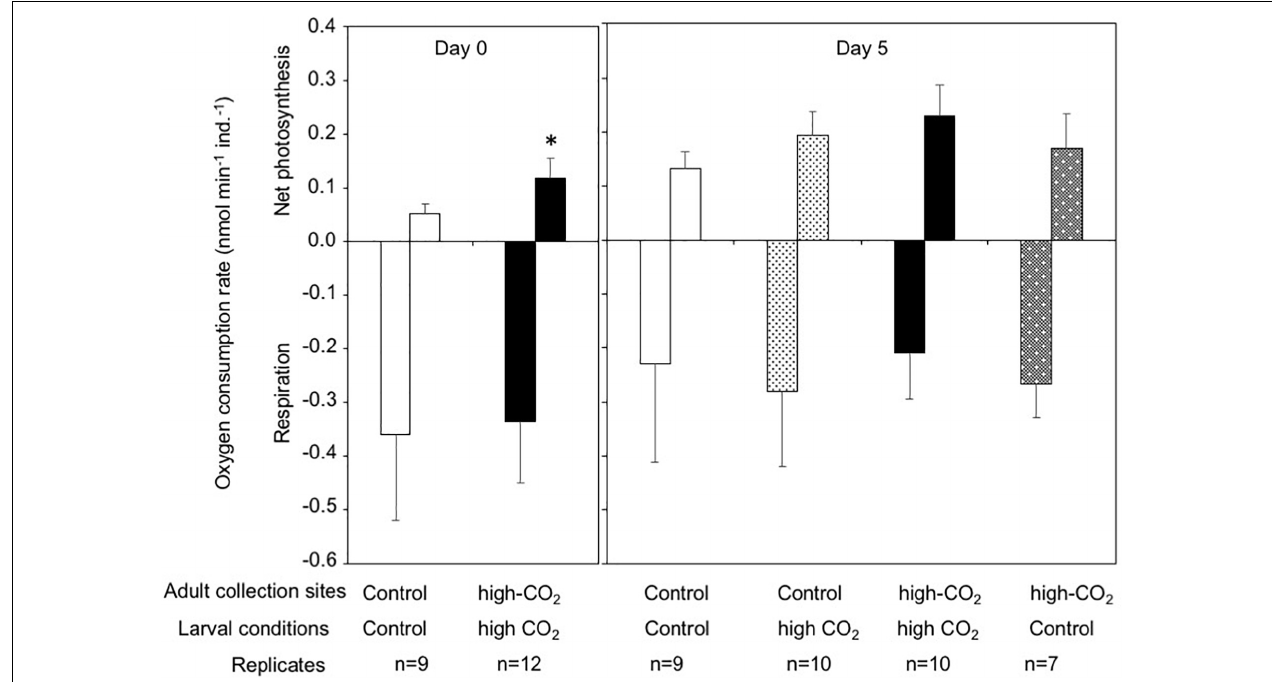
FIGURE 1 | Net photosynthesis and respiration rates of Pocillopora acuta larvae released from adults collected at control (white bar) and high-CO 2 sites (black bar) at Day 0, and at Day 5 after larvae from the control site were reared under control (white bar) or high CO 2 (light gray) conditions, and larvae from high-CO 2 site were reared under high CO 2 (black bar) or control (dark gray) conditions. At Day 0, differences among larvae from control and high-CO 2 sites were compared by t -test, and asterisk shows significant differences. At Day 5, both net photosynthesis and respiration did not show significant differences among larvae originating from control and high CO 2 parents, or among larvae cultured under control and high CO 2 conditions. The replicate number are shown as n in the graph. Average ±